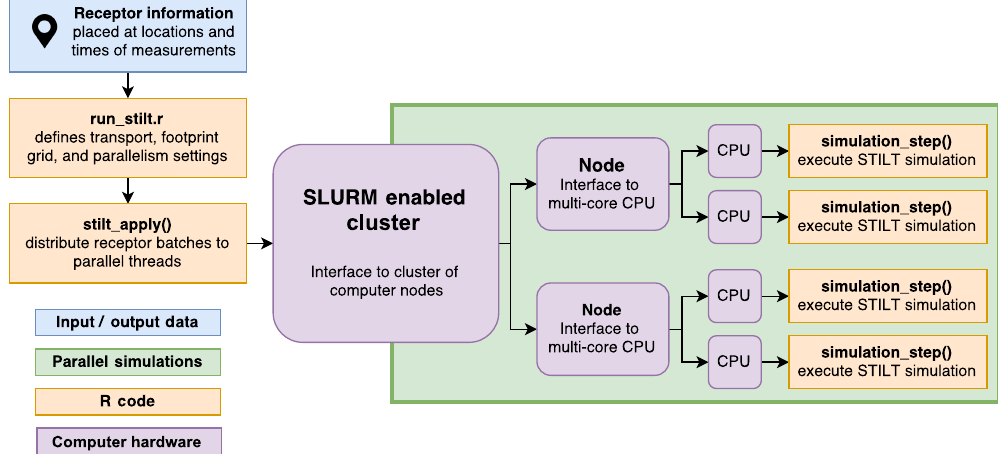
Figure 2. Receptor batches are distributed across parallel threads to enable multiple concurrent simulations. Provided memory limits are not exceeded, the total simulation time decreases linearly with the number of CPU cores available.